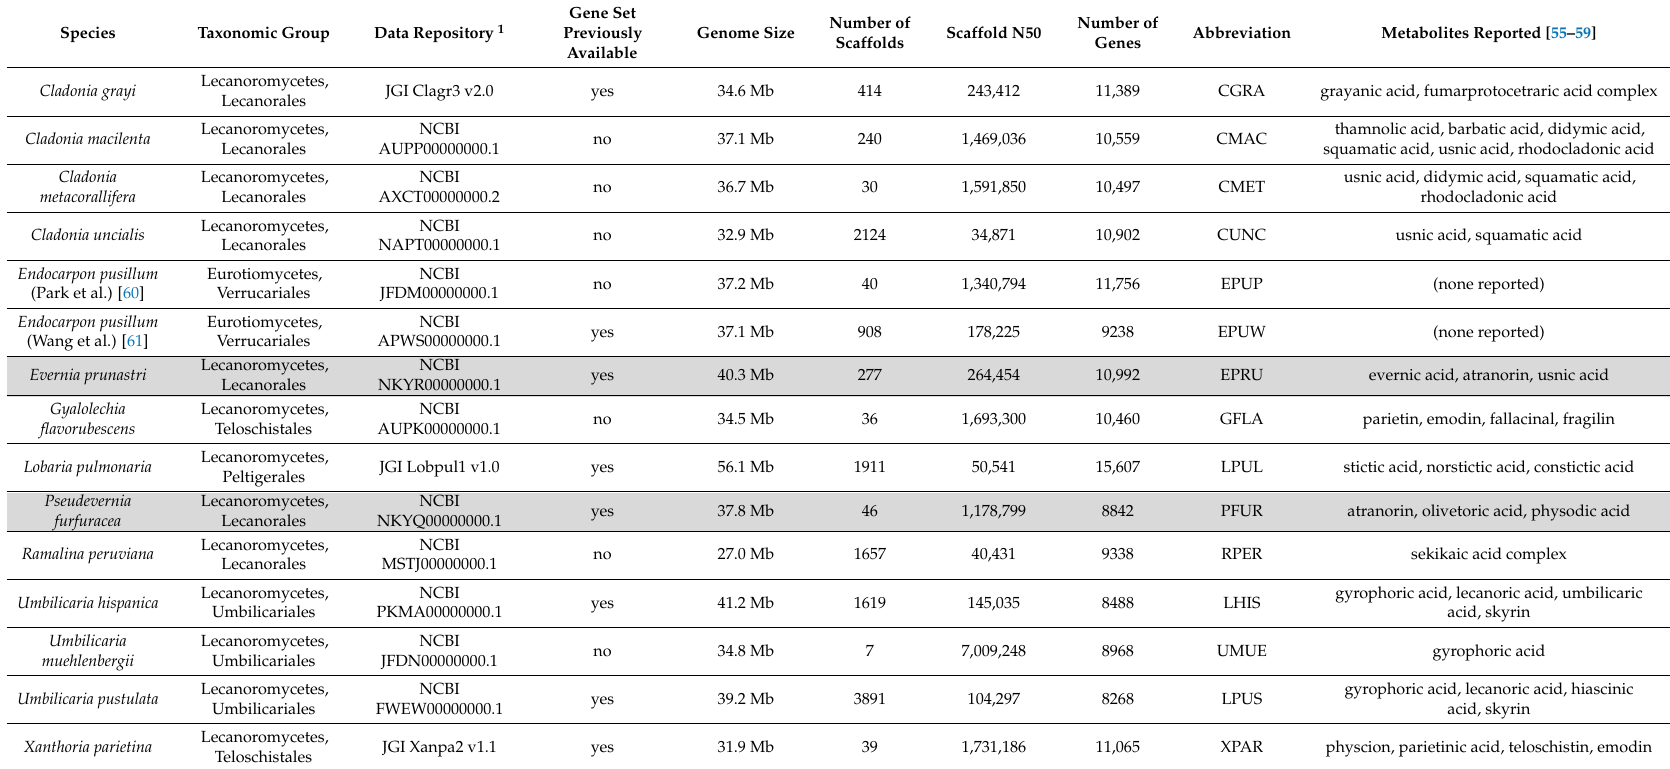
Table 1. Overview of genomes of lichen-forming fungi used in this